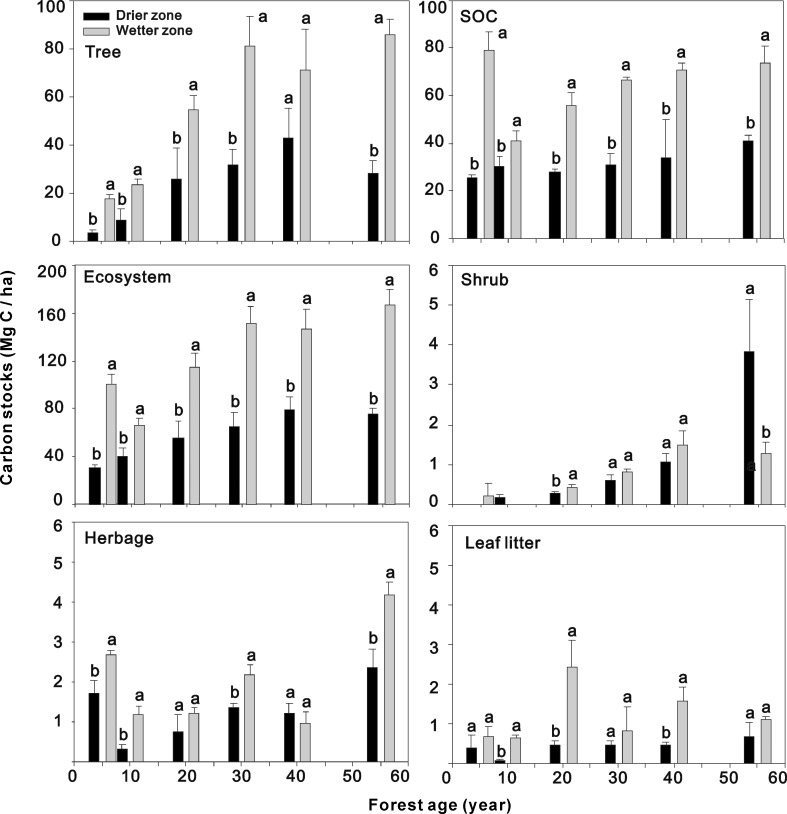
Spatial variety of component C stocks between drier region and wetter region across the chronosequence.ANOVA test was conducted under P < 0.05, the bars represent standard deviation and the letters represent the significance of difference, no shrub was found at 5-y-old stand in drier zone and at 10-y-old stand in wetter zone, respectively.